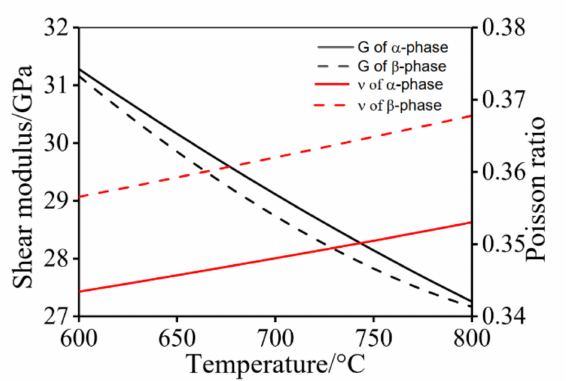
Figure 7. Calculated data using JMatProV7.0: shear modulus and Poisson ratio of α and β